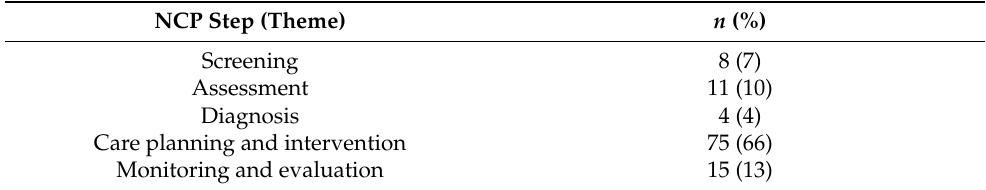
Table 4. Identified opportunities for systematised, interdisciplinary alternatives mapped to the nutrition care process